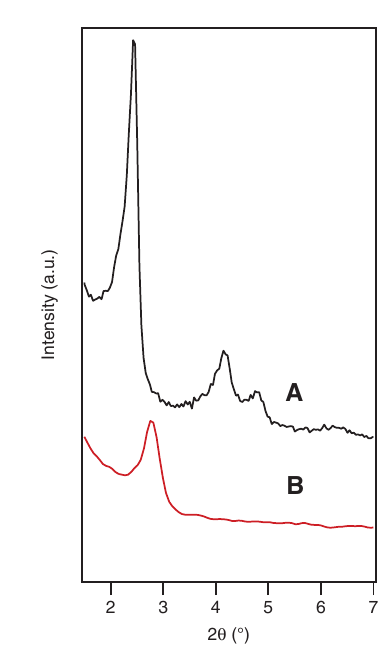
Figure 1: SEM images of (A) FSM-16 and (B) FSM-16-SO